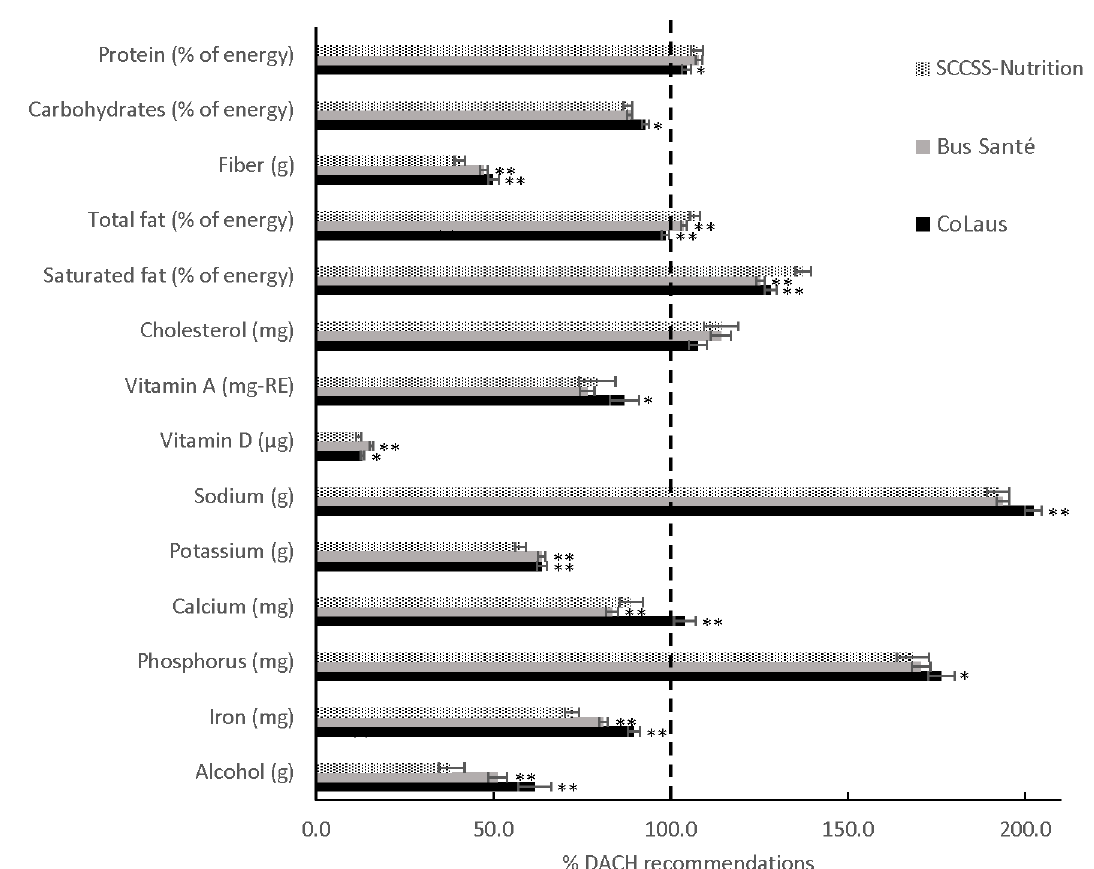
Figure 1. Nutrient intake compared with DACH recommended intake or limit in childhood cancer survivors (SCCSS- Nutrition) and the general population in Switzerland (Bus Santé and CoLaus) a . The length of the bar per nutrient corresponds to the percentage of mean intake (95% CIs) compared to the recommended intake level * 100. Recommended intake is estimated on the basis of age and sex according to dietary recommendations for Germany (D), Austria (A) and Switzerland (CH) (DACH) 2015, weighted by the age and sex distribution per study population. For alcohol intake the maximum tolerated dosage was taken. Nutritional goals were set at 100 when the mean intake met the recommended intake or the maximum tolerated dosage. a Standardized on sex and age at survey according to CCSs. * p < 0.05 compared to CCSs. ** p < 0.001 compared to CCSs.